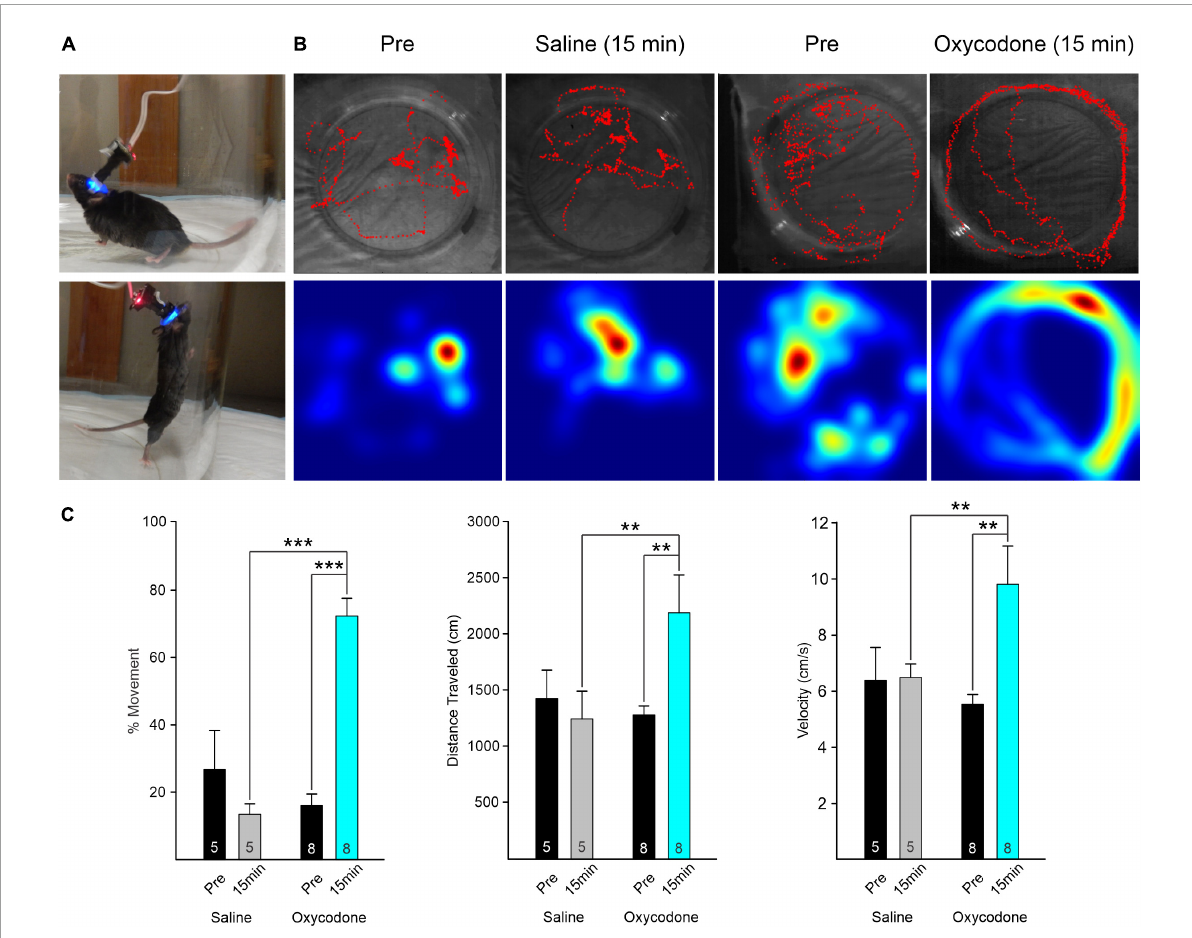
FIGURE1 (A) Mouse behavior in observation chamber with Miniscope attached. The mouse could move and rear freely. (B) Movement of the mouse was tracked using a webcam placed above the arena. Red traces (upper panels) track the behavior of the mice during the ∼ 5 min recording. Heat maps (lower panels) indicate the place where the mouse spent most of the time. Movement analysis was performed with ImageJ and Manual Tracking plugin. Behavior of an A2A-Cre mouse before (Pre) and 15 min after injection of saline. The movement patterns were similar. Traces of the same A2A-Cre mouse before (Pre) and 15 min after injection of oxycodone (3 mg/kg). Mouse continuously circled the outer perimeter of the arena after oxycodone. In addition, we observed a Straub tail ∼ 3 min after injection and absence of rearing. (C) Graphs indicate the % of frames that the mouse was moving (left graphs) before and 15 min after injection of saline or oxycodone. In saline, there was a statistically non-significant reduction in movement. After oxycodone, movement increased significantly. Middle graphs indicate total distance traveled during the recording session. The distance increased significantly after oxycodone and the velocity (right graphs) increased likewise. Numbers within the bar graph indicate the number of videos examined. Data were analyzed by two-way RM ANOVA with Holm–Sidak post-hoc t -test, ** p < 0.01, *** p <